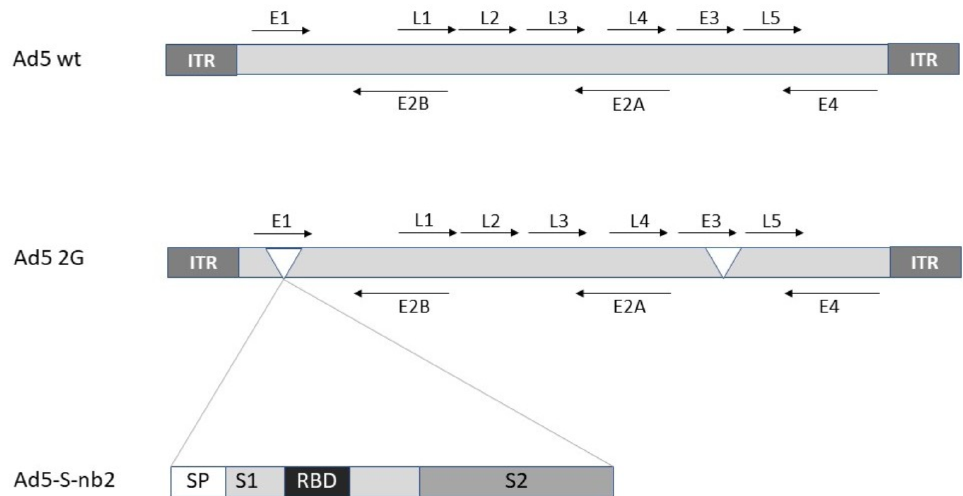
Figure 1. Adenovirus expression vector engineering for SARS-CoV-2 S expression. Ad5 wt, aden- ovirus type 5 wild type; Ad5 2G, second generation Ad5 vector with deletions in E1 and E3 genes; Ad5-S-nb2, Ad5-based vector expressing the SARS-CoV-2 S protein. E, early genes; L, late genes; RBD, receptor binding domain; S1 and S2, regions of S protein.